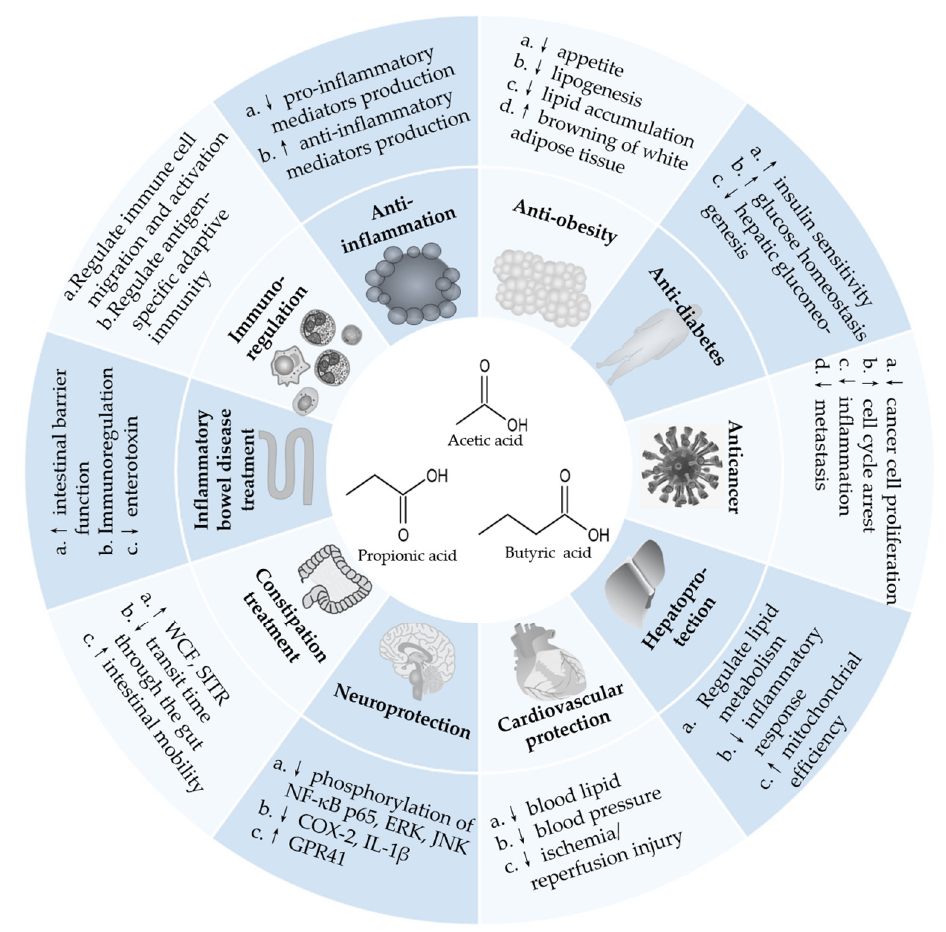
Figure 2. Health benefits and the related mechanisms of SCFAs. ↓ represents decrease, and ↑ represents increase. Abbreviation: COX-2, cyclooxygenase-2; GPR41, G-protein-coupled receptor 41; IL, interleukin; NF- κ B, nuclear factor-kappa B; SITR, small intestinal transit rate; WCF, water content of feces.